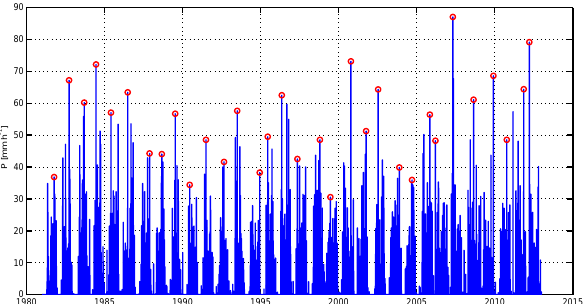
Figure 4. Hourly rainfall Can Tho gauge 1982–2012 with annual maxima marked by red